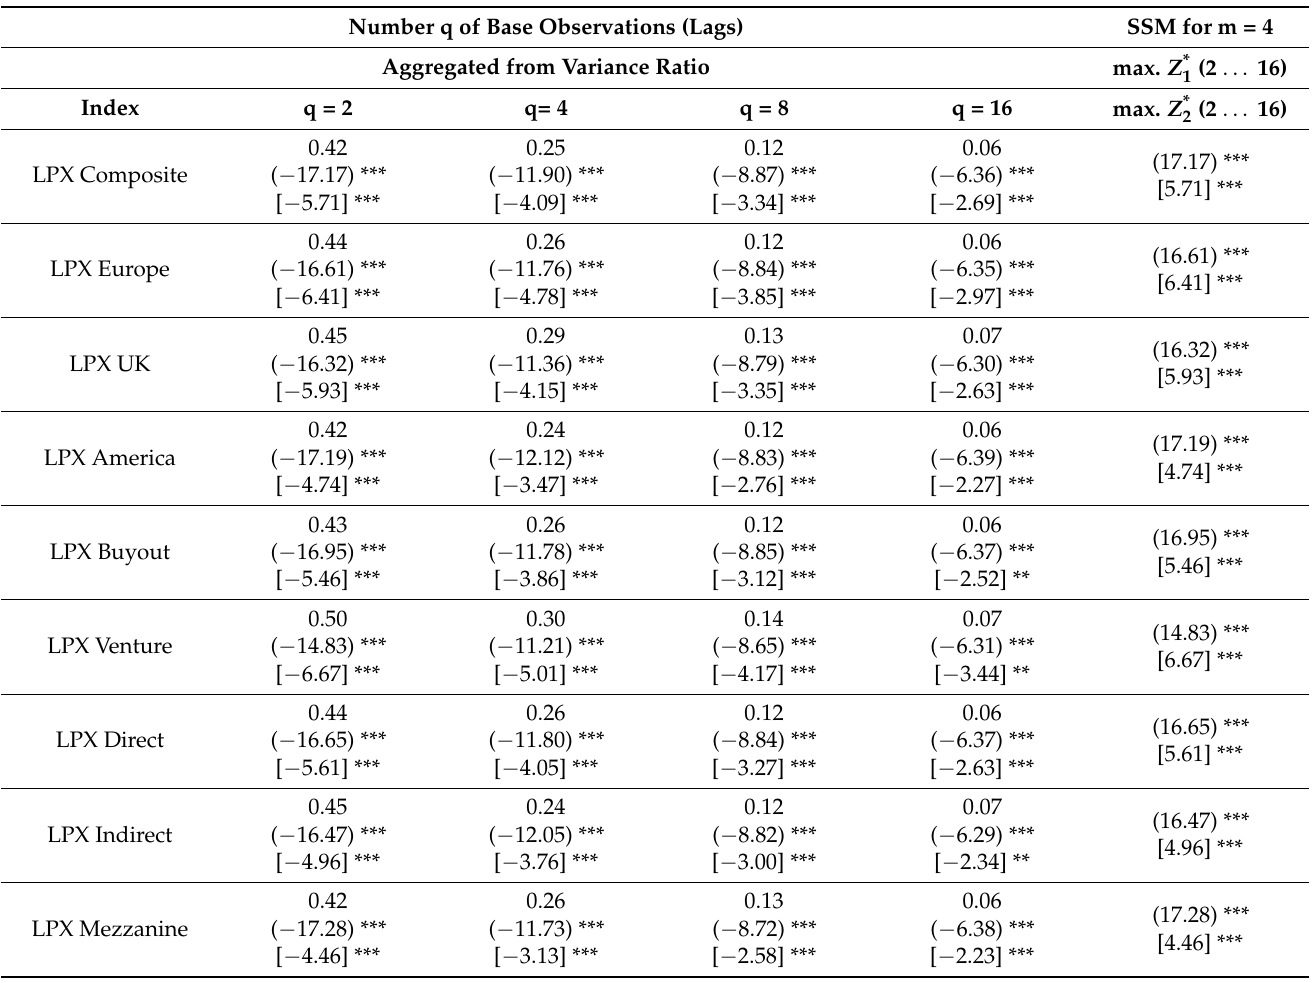
Tables 4–6 report the results of the variance ratio test for the full period and the pre- crisis and the post-crisis periods. During the full period displays in Table 4, all indices exhibit a variance ratio less than one, indicating a mean reversion process. Table 4. Variance ratio estimates VR(q) and variance ratio test statistics for listed private equity index returns during the full period (January 2004 to December 2020). Number q of Base Observations (Lags) SSM for m =